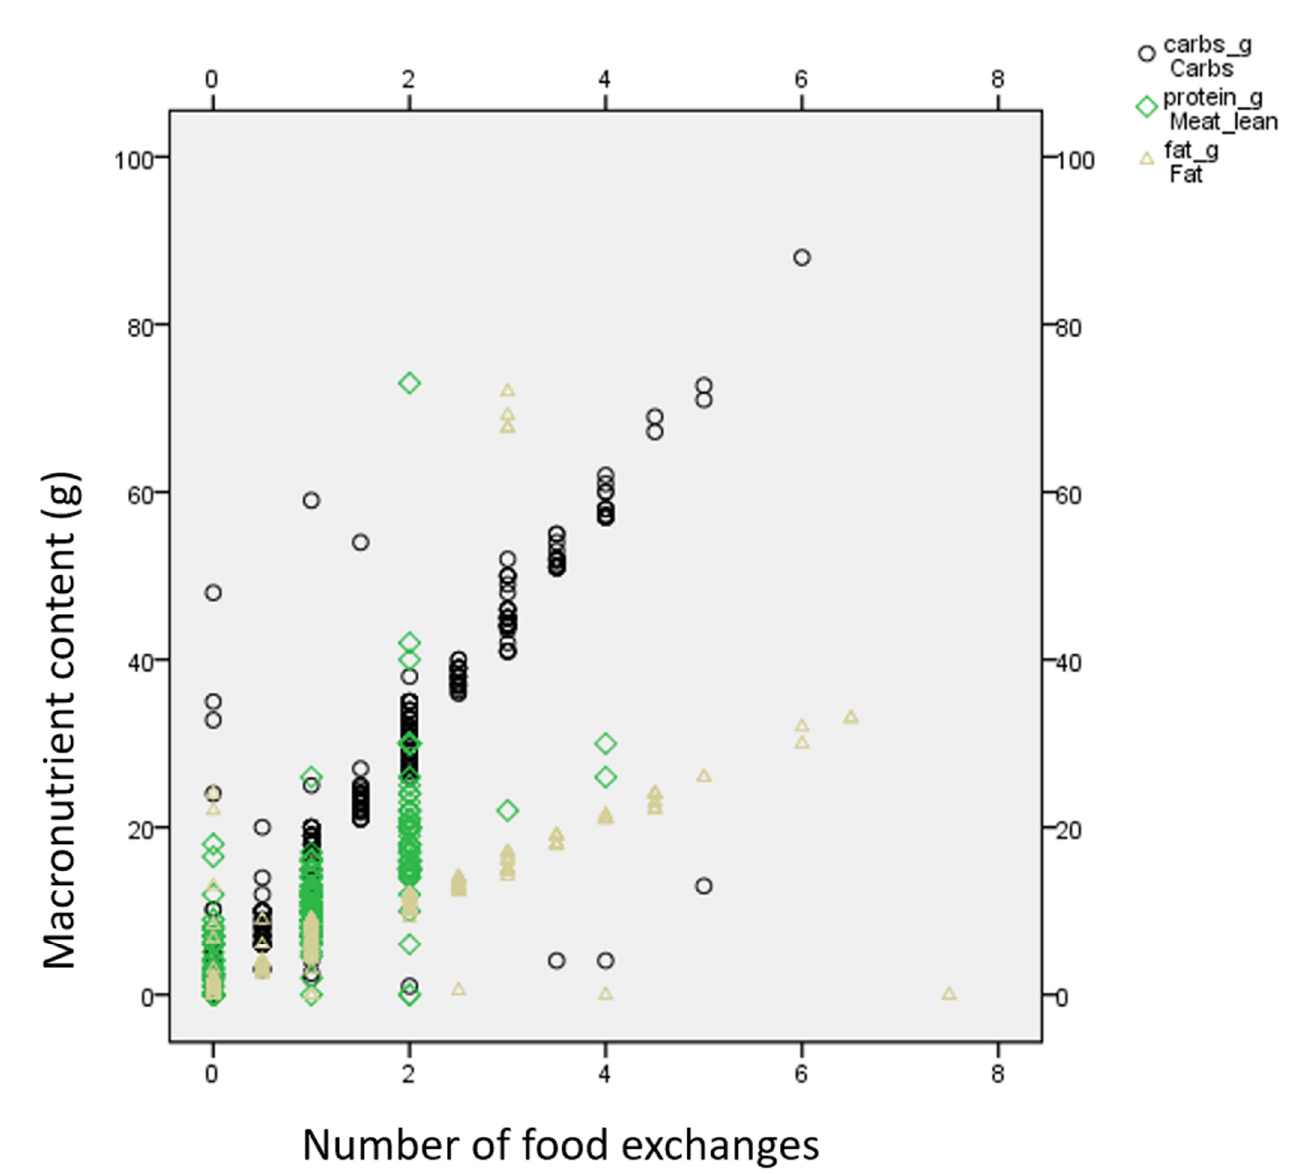
Figure 1. Scatter dot graph between grams of macronutrients and calculated food exchanges.